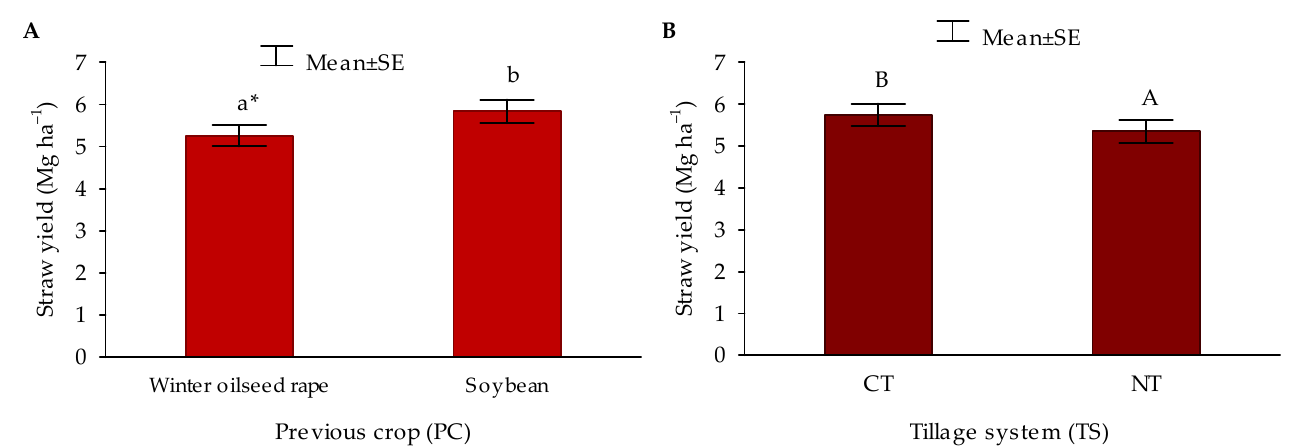
Figure 3. Winter wheat straw yield depending on previous crop ( A ) and tillage system ( B ) (mean for 2014–2017). CT— Conventional tillage; NT—No-tillage. * Different letters denote significant differences ( p ≤ 0.05). The lowercase letters refer to previous crops (PC); the capital letters refer to tillage systems (TS).